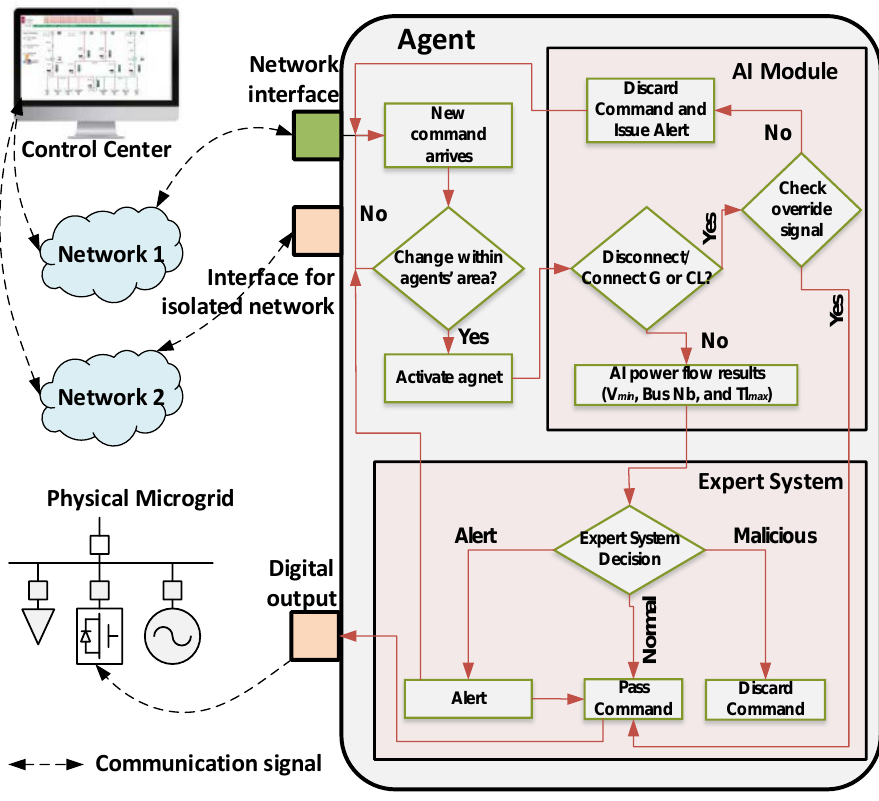
Figure 3. Agent operation and the physical-model-checking approach.